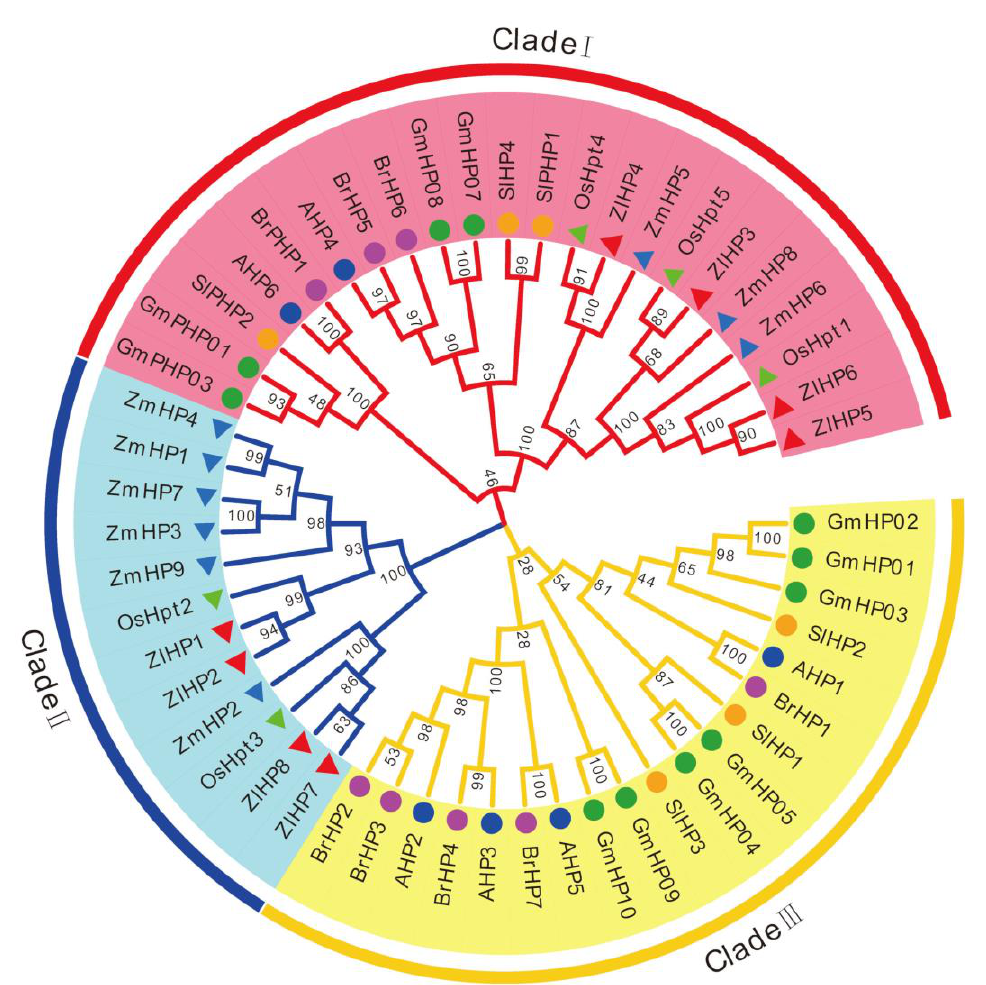
Figure 3. Phylogenetic relationship of phosphotransfer proteins (HP) and related proteins in Arabidopsis , rice, maize, soybean, Chinese cabbage, tomato, and Z. latifolia .